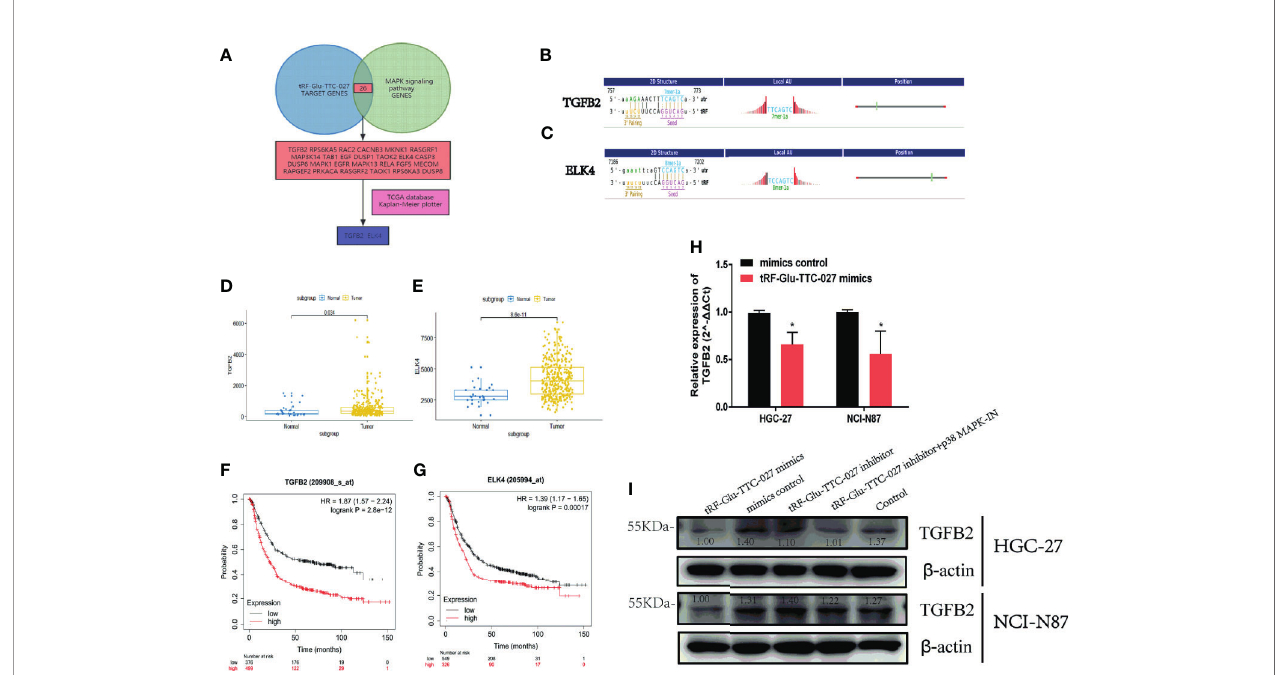
FIGURE 7 | tRF-Glu-TTC-027 regulated the MAPK signaling pathway signi fi cantly. (A) we discovered 26 possible target genes by taking the intersection of tRF-Glu- TTC-027 target genes and genes in the MAPK signaling pathway. (B, C) TGFB2 and ELK4 were selected as their 3 ’ UTR owned the target sites with tRF-Glu-TTC- 027. (D, E) TGFB2 and ELK4 were highly expressed in GC compared with NATs. (F, G) TGFB2 and ELK4 were associated with poor prognoses. (H, I) RNA and protein levels of TGFB2 were regulated by tRF-Glu-TTC-027 to varying degrees. *P < 0.05, Student ’ s